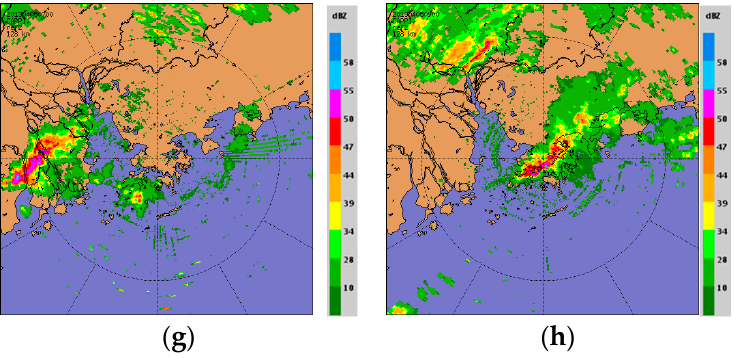
Figure 4. Reflectivity and motion fields based at 07:00 (HKT/UTC + 8) on 5 April 2013 (base time). ( a ) Reflectivity and motion field of TREC at base time; ( b ) Forecast reflectivity of TREC at 2 h from the base time; ( c ) Reflectivity and motion field of MOVA at base time; ( d ) Forecast reflectivity of MOVA at 2 h from the base time; ( e ) Reflectivity and motion field of ROVER at base time; ( f ) Forecast reflectivity of ROVER at 2 h from the base time; ( g ) Actual radar reflectivity at base time; and ( h ) Actual radar reflectivity at 2 h from the base time.